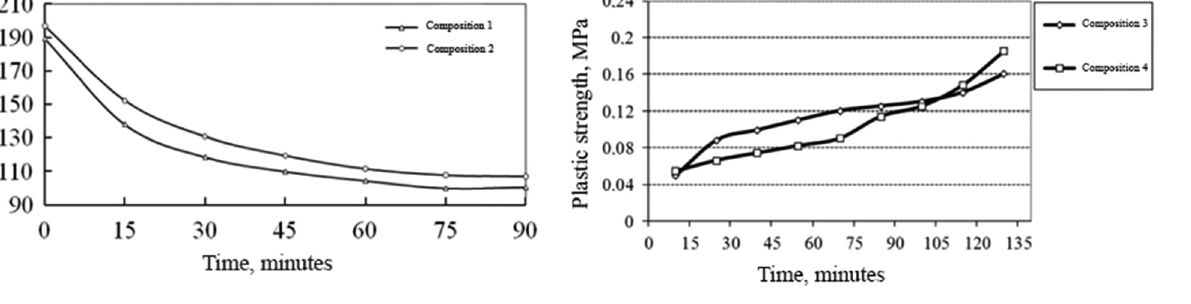
Figure 11: Plastic strength of cement paste with nano - carbon